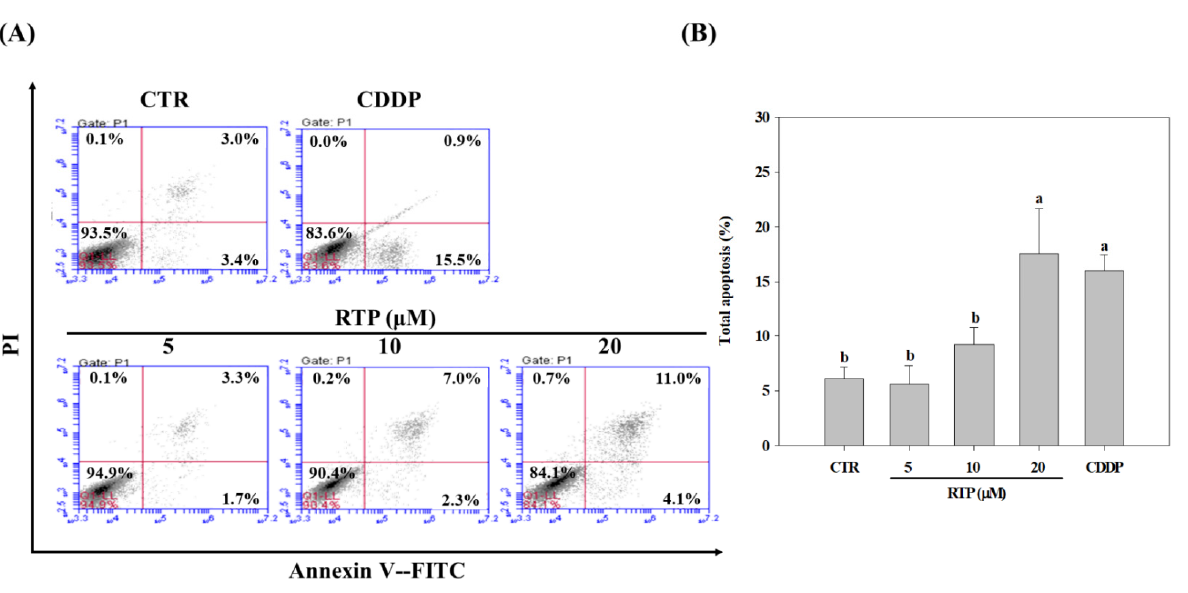
Figure 3. Effects of rutaecarpine (RTP) on apoptosis of human esophageal squamous cells CE81T/VGH at 72 h. Cells (1 × 10 5 cells/mL) were treated with RTP (5, 10, and 20 μ M) or cisplatin (CDDP; 5 μ M) for 72 h. ( A ): Annexin V-FITC/PI staining cells were measured using flow cytometry. ( B ): The percentages of apoptosis among different experiment groups. CTR represents the control group. Values (means ± SD, n = 3) not sharing a common lower case letter are significantly different ( p <